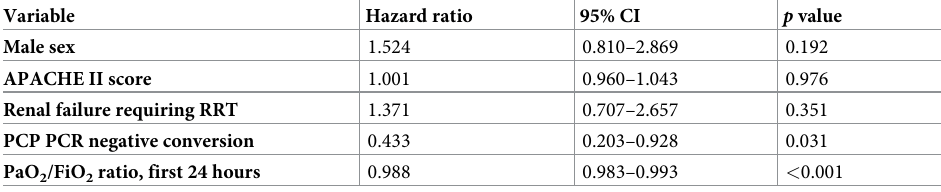
Table 3. Factors associated with mortality in non-HIV PCP patients with respiratory failure in a multivariate